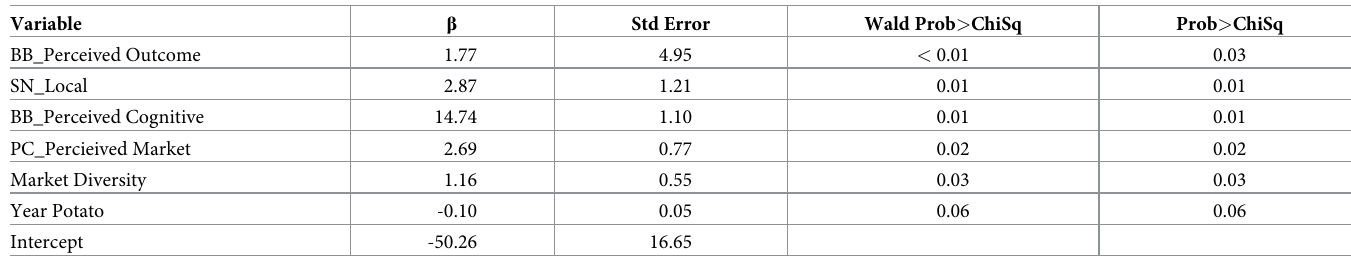
Table 5. Factors influencing the adoption of SCs determined by logistic regression � .